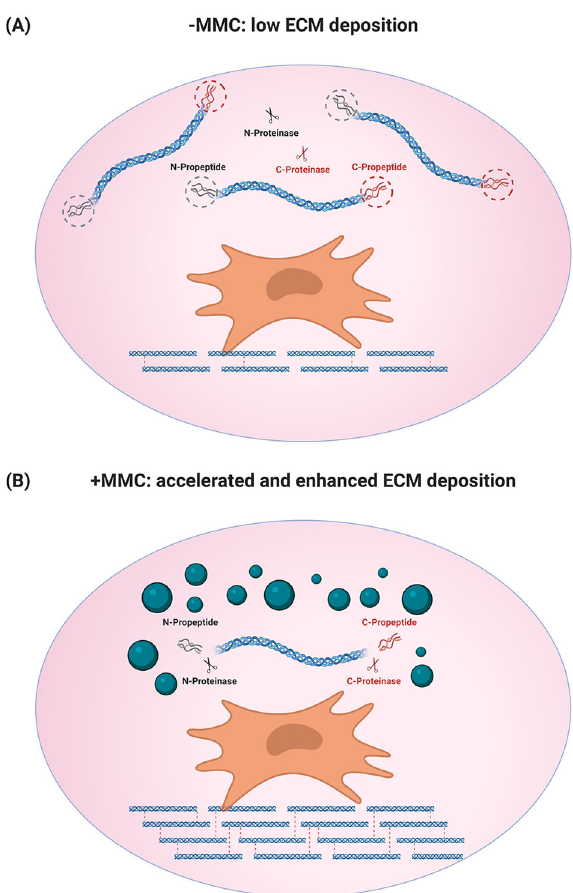
Fig. 3 Macromolecular crowding in cell culture. In the dilute cell culture context ( − MMC), the N- and C-proteinases and the water- soluble procollagen are diffused, and respectively deactivated and dissolved, resulting in very low amounts of deposited ECM ( A ). Under macromolecular crowding conditions ( + MMC), the diffusion of procollagen and N- and C-proteinases is restricted, resulting in enhanced and accelerated ECM deposition ( B ). The fi gure was created with